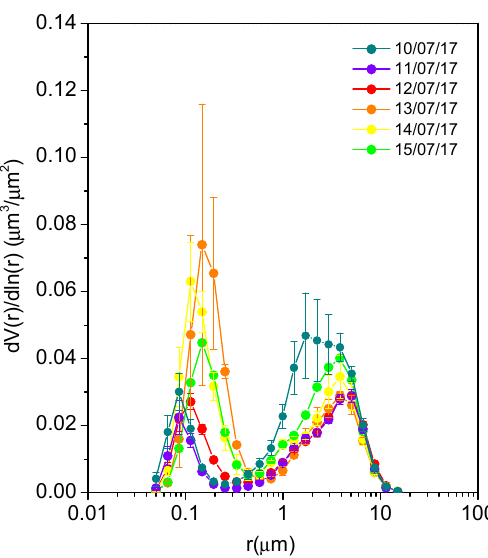
Figure 9. Daily columnar volume particle size distributions dV(r)/dln(r) obtained from sun photometer measurements carried out in Naples from 10 to 15 of July 2017. The mean standard deviation was chosen as uncertainty for the data.